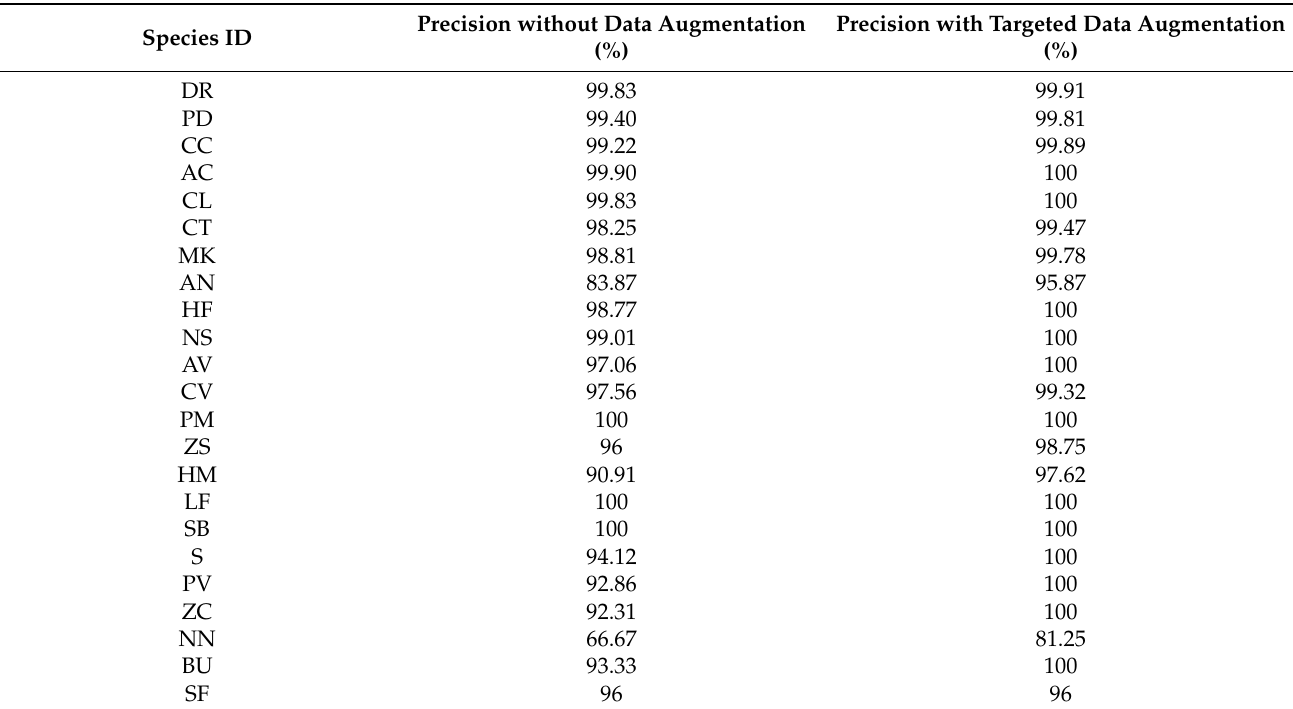
Table 3. Precision for 23 fish species of the FRGT dataset using CNN transfer learning approach without and with targeted data augmentation.